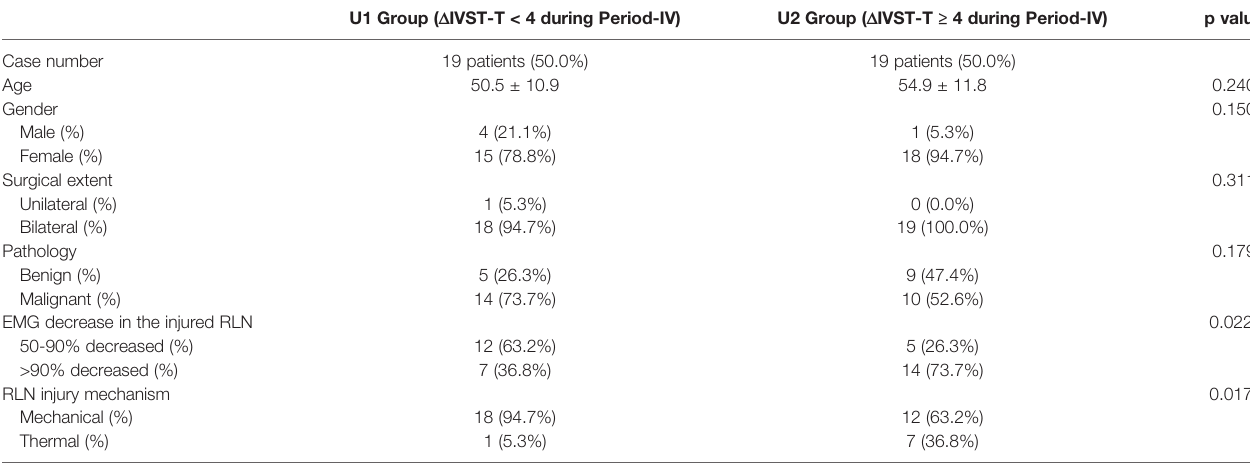
TABLE 2 | Demographic characteristic of patients in U Group with different subjective voice outcomes during long-term postoperative period